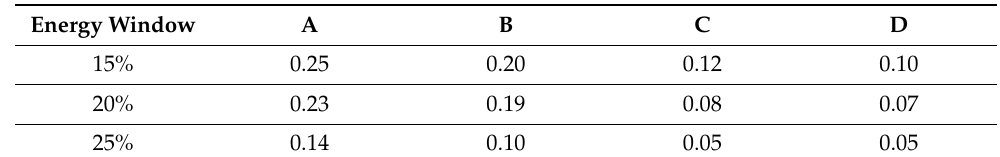
Table 2. Values of defect contrast at an inferior location in SPECT image in different positions of the phantom for three energy windows.